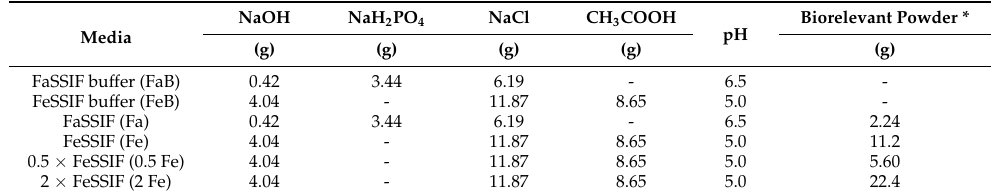
Table 1. The composition of a liter of